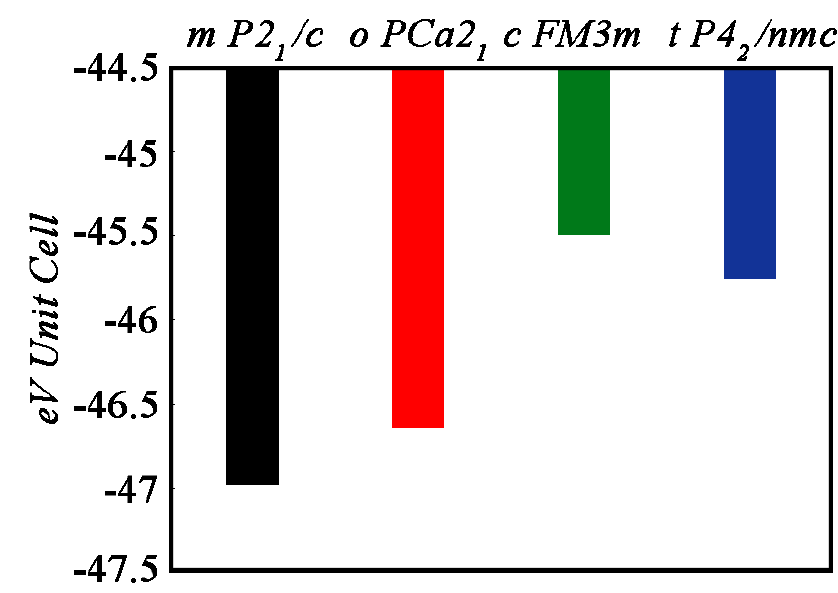
Figure 2. Cohesive energy of HfO 2 polymorphs.